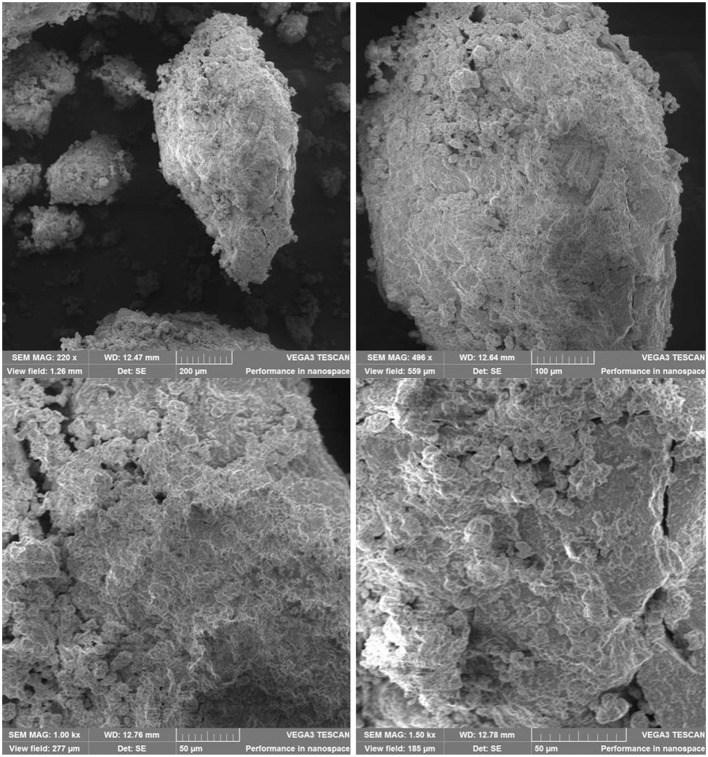
Aspect of structures from sample PU_1 at different magnifications.